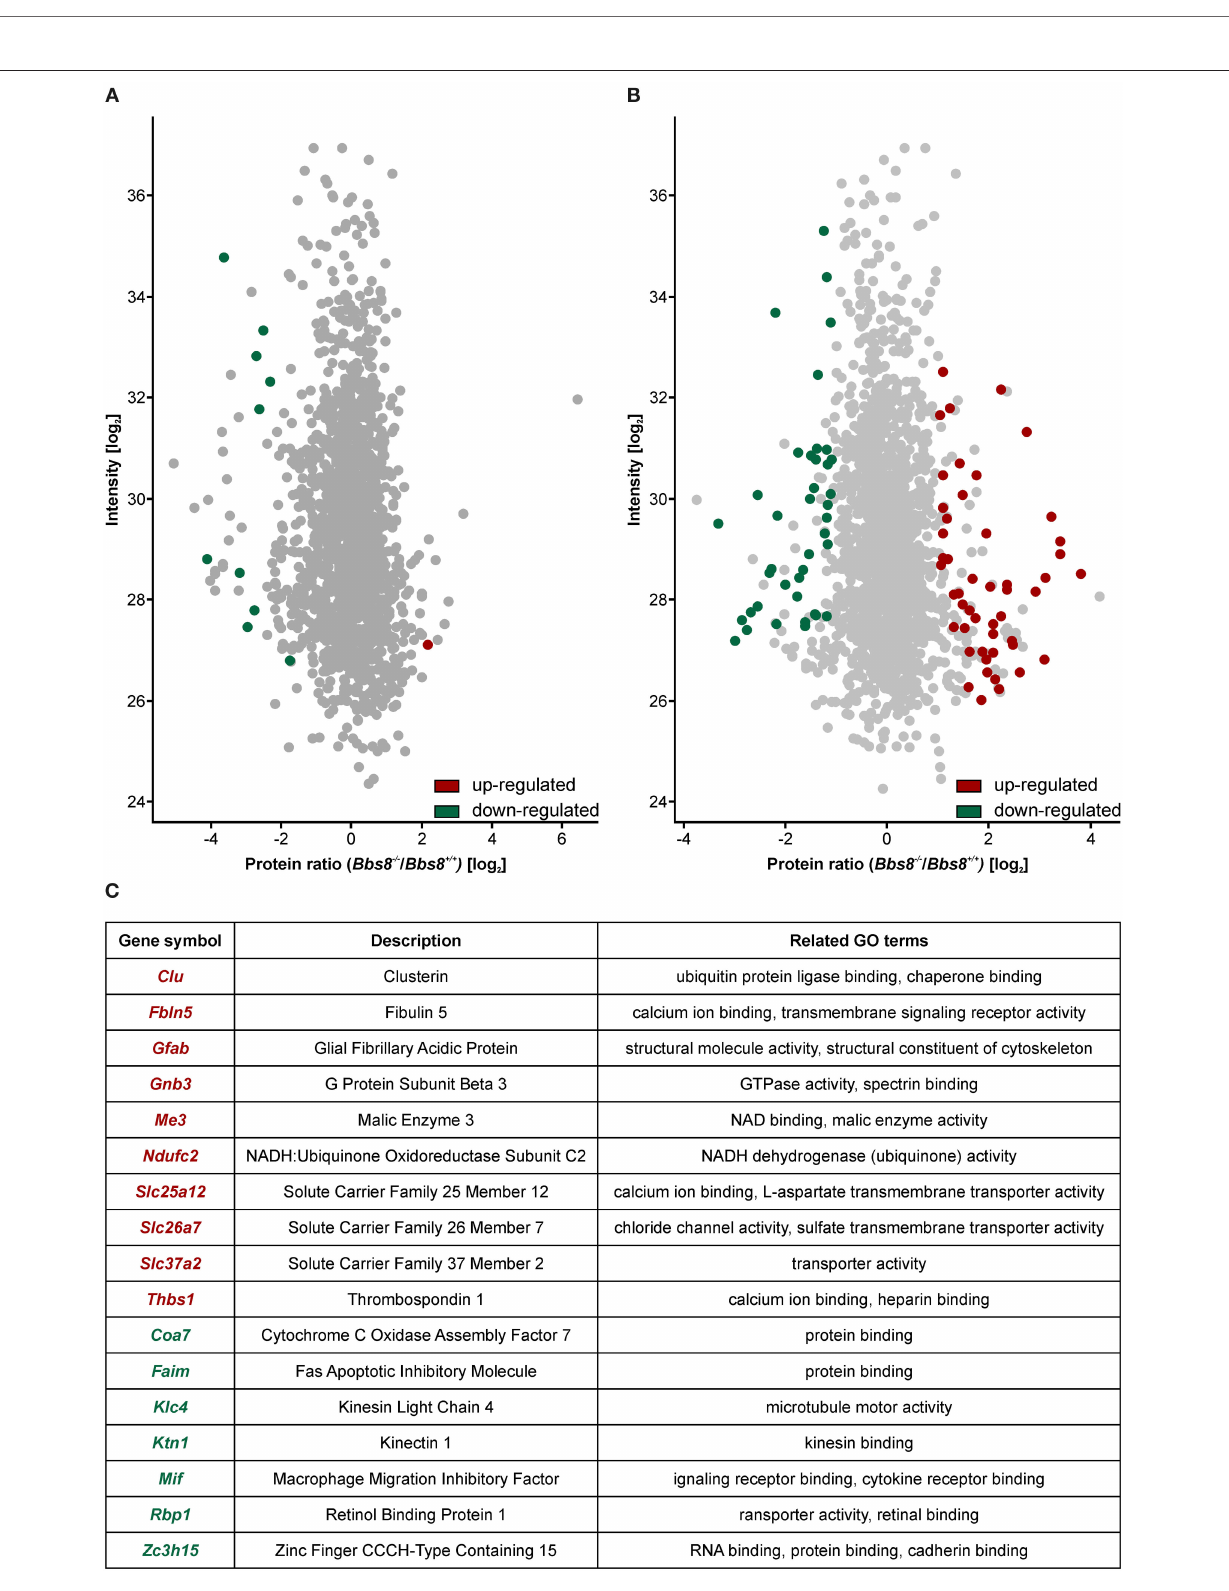
Frontiers in Cell and Developmental Biology |